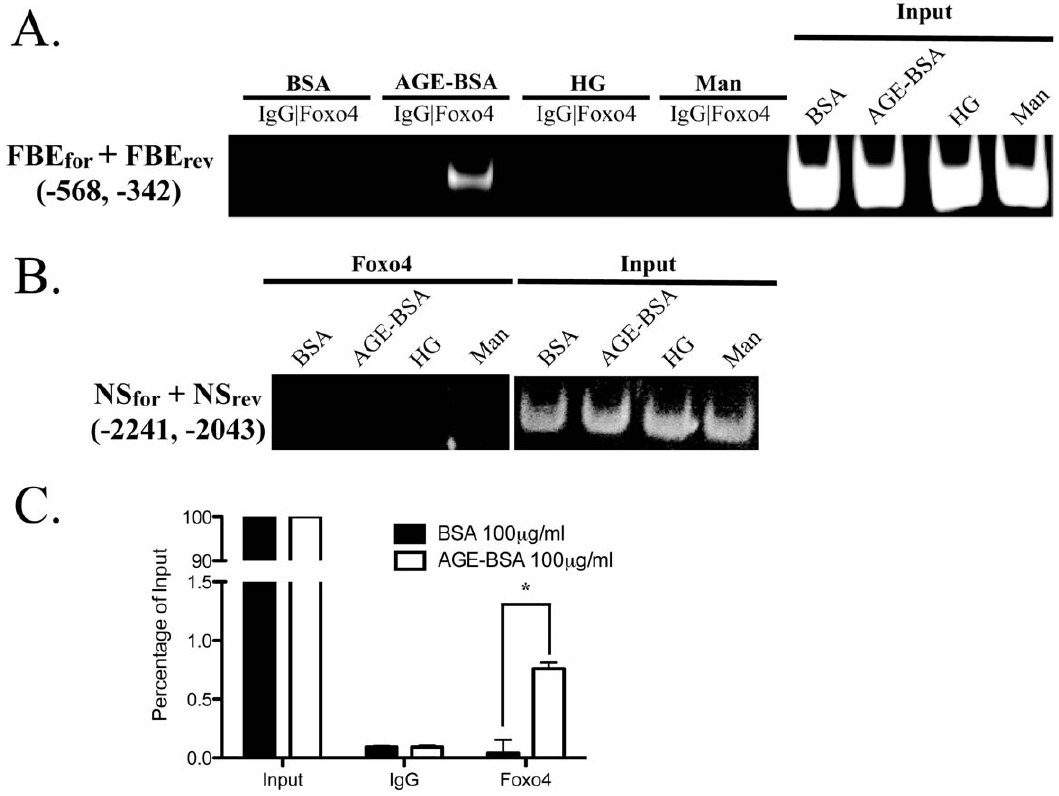
Figure 1. Binding of Foxo4 to the Bcl2l11 promoter. Conditionally immortalized podocytes were treated with either AGE-BSA (100 m g/ml) or BSA (100 m g/ml) as control and 30 mM of hyperglycemia (HG) or 30 mM of mannitol (Man) as osmotic control for 2 h. Binding of Foxo4 to a predicted forkhead binding elementer (FBE) in the promoter region of Bcl2l11 was characterized by chromatin immunoprecipiation (ChIP) using either an anti-Foxo4 antibody (Foxo4) or normal goal IgG (IgG). (A) Binding was assessed using primers flanking FBE (FBE for and FBE rev ) and immunoprecipitated DNA samples as PCR templates. (B) Primers flanking a region 2 2241to 2 2043upstreamof thetranslational startsitewere usedina PCR reactionwith Foxo4immunoprecipitated DNA as templates to assess non-specific immunoprecipitation. Representative images of products of endpoint PCR resolved on agarose gels are shown. (C) Data of quantitative realtime PCR of ChIP DNA using primers flanking the FBE. Results from 3 independent sets of ChIPs. * p , 0.05.